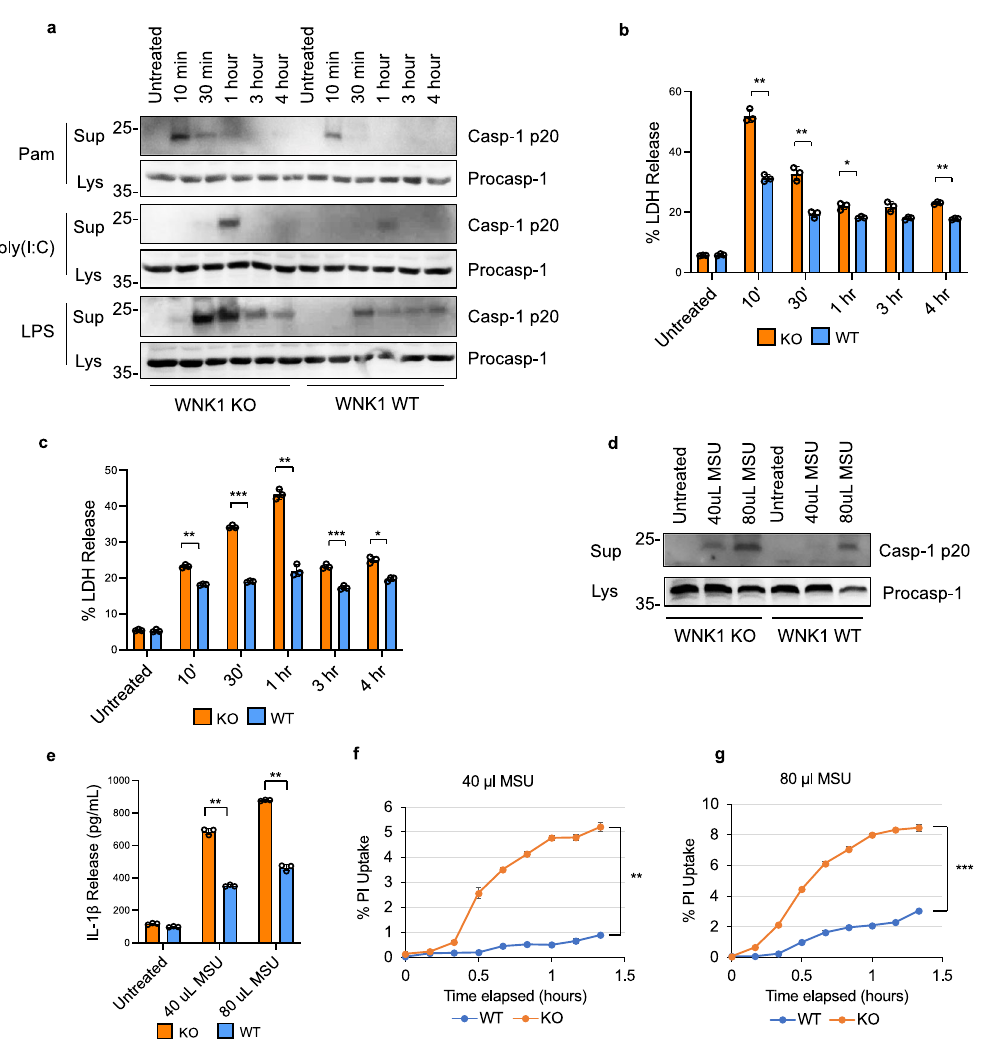
Fig. 2 Tamoxifen-induced WNK1 knockout increases NLRP3 in fl ammasome activation in macrophages. a Immunoblots of caspase-1 in culture supernatant (Sup) and cell lysates (Lys) of immortalized Wnk1 fl ox/ fl ox -CreERT2 + (WNK1 KO) or Wnk1 + / + (WT) macrophages treated with tamoxifen for 48 h prior to stimulation with Pam3CSK4, Poly(I:C) or LPS for the indicated times followed by ATP (45 min). LDH release of immortalized Wnk1 fl ox/ fl ox - CreERT2 + (WNK1 KO) or Wnk1 + / + (WT) macrophages treated with tamoxifen for 48 h prior to stimulation with Pam3CSK4 ( b ) or Poly(I:C) ( c ) for the indicated times followed by ATP (45 min). P values for b are 0.321, 0.00473, 0.0036, 0.0475, 0.0754, and 0.0027; c are 0.716, 0.0055, 0.0004, 0.0006, 0.0001, and 0.0191. d Immunoblots of caspase-1 in culture supernatant (Sup) and cell lysates (Lys) of immortalized Wnk1 fl ox/ fl ox -CreERT2 + (WNK1 KO) or Wnk1 + / + (WT) macrophages treated with tamoxifen for 48 h prior to stimulation with LPS for 3 h followed by MSU (40 uL or 80 uL 5 mg mL − MSU) for 80 m. IL-1 β release ( e ) and propidium iodide uptake ( f , g ) of immortalized Wnk1 fl ox/ fl ox -CreERT2 + (WNK1 KO) or Wnk1 + / + (WT) macrophages treated with tamoxifen for 48 h prior to stimulation with LPS for 3 h followed by MSU (40 uL ( f ) or 80 uL ( g ) 5 mg mL − MSU) for 80 m. P values for e are 0.061, 0.00077, and 0.00094; f is 0.0005; g is 0.00034. Results are representative of at least three independent experiments performed in duplicate or triplicate. Error bars in b , c , e – g are presented as mean values ± standard deviation (S.D.), with n = 3. Two-sided Student ’ s t test, * p < 0.05, ** p < 0.005, *** p <